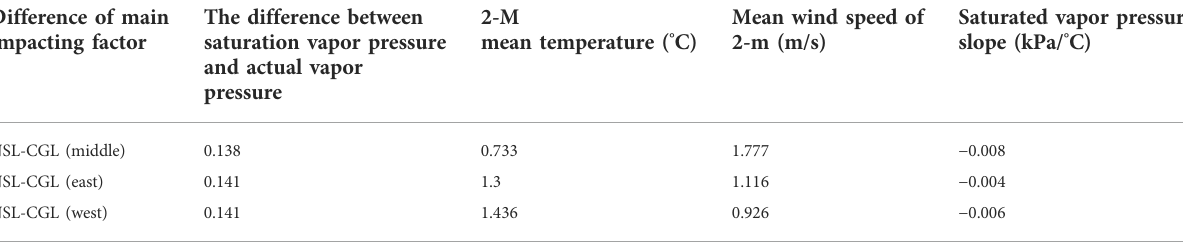
TABLE 2 Difference in main impacting factors between CGL and NSL (mean values of 8,760 times within a year).